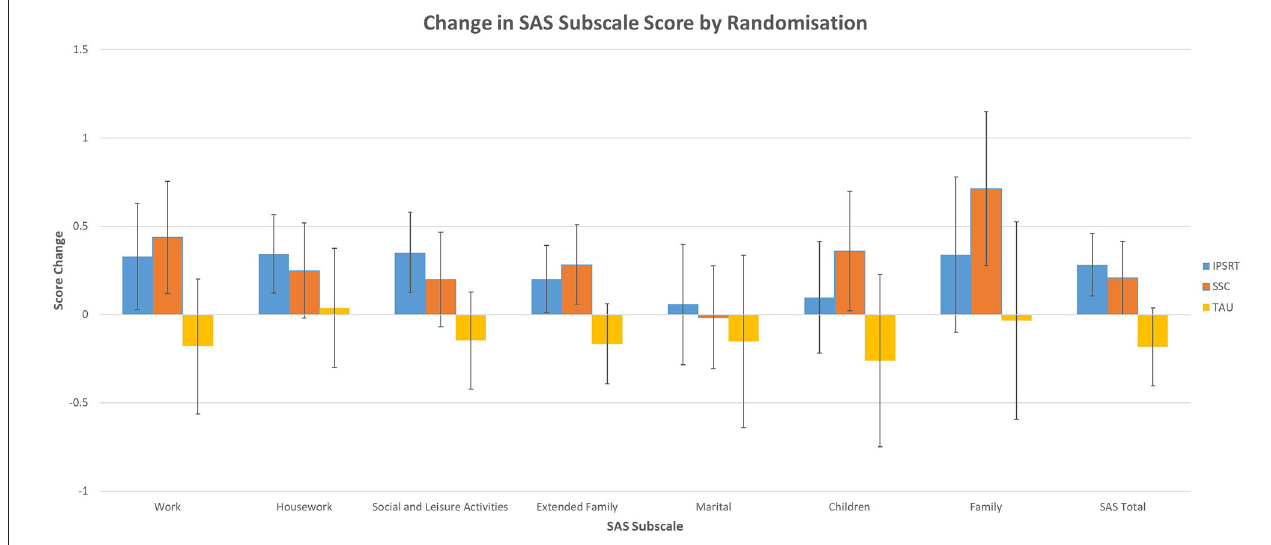
TABLE 2 | Treatment randomization on SAS subscale score change—significant predictive values from GLM.